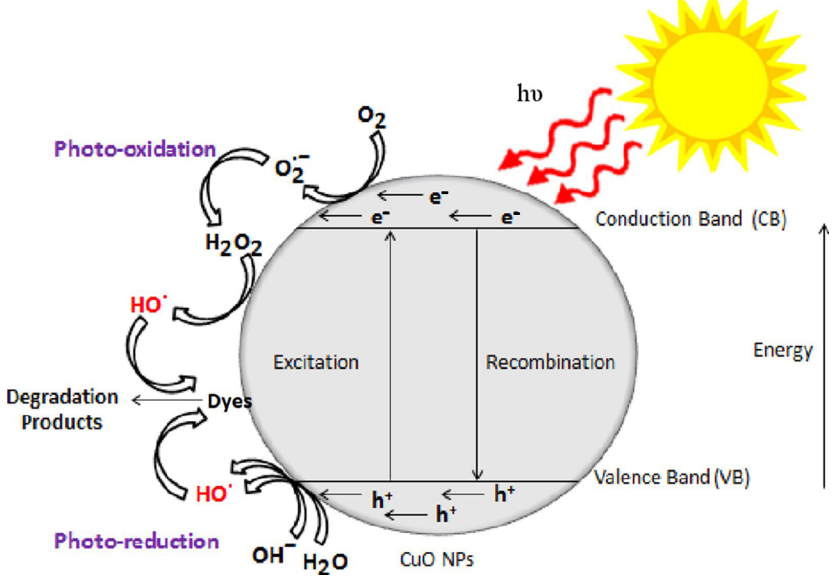
Figure 10. Schematic representation of photocatalytic degradation of